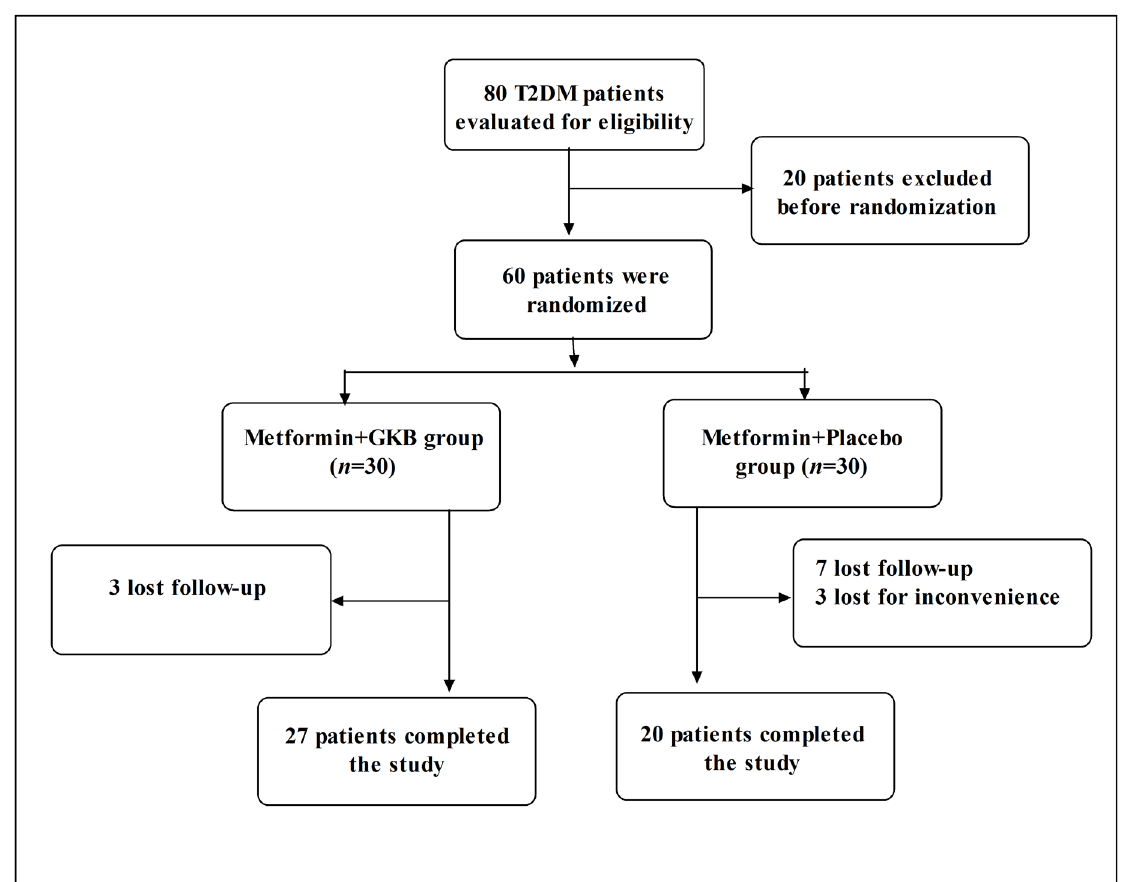
FIGURE 1 - Flowchart shows the screening, recruitment, and randomization of patients. T2DM, type 2 diabetes mellitus; GKB, Ginkgo biloba ; n , number of